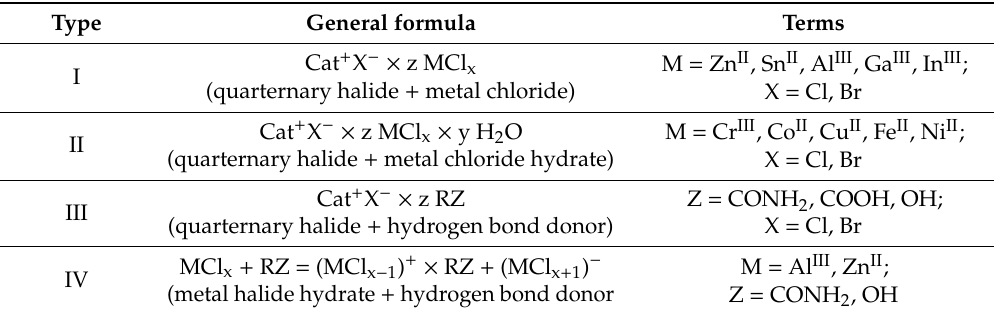
Table 1. Classification of deep eutectic solvents